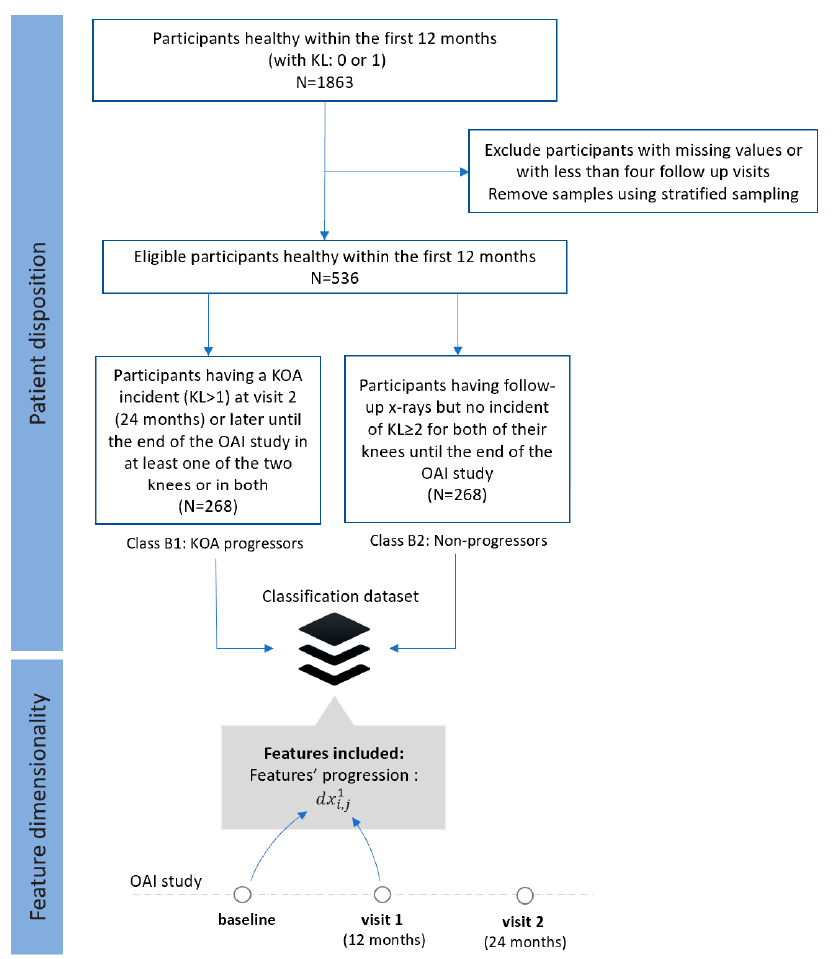
Figure 2. Flow chart of study design for dataset B.